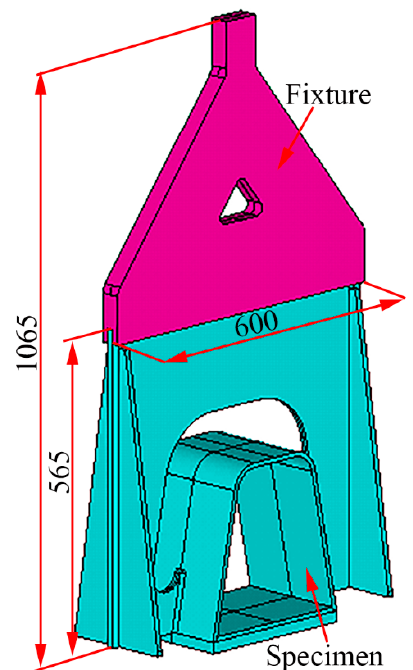
Figure 7. Specimen and fixture (in mm).